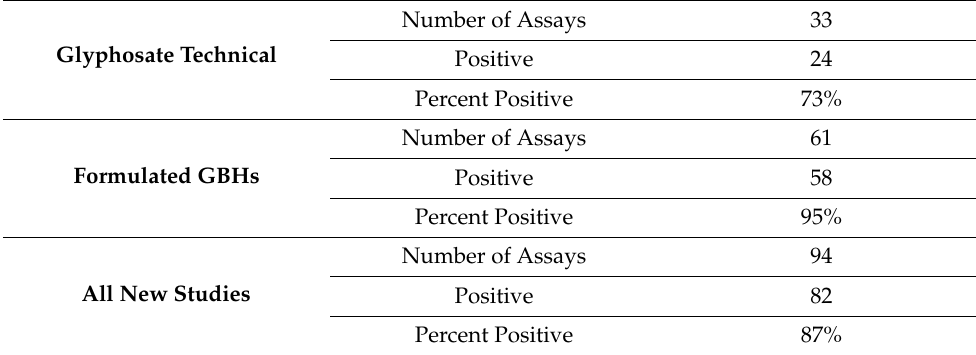
Table 6. Overall Results of Genotoxicity Assays Published Since the 2015 EPA and IARC Reviews of Glyphosate and GBH